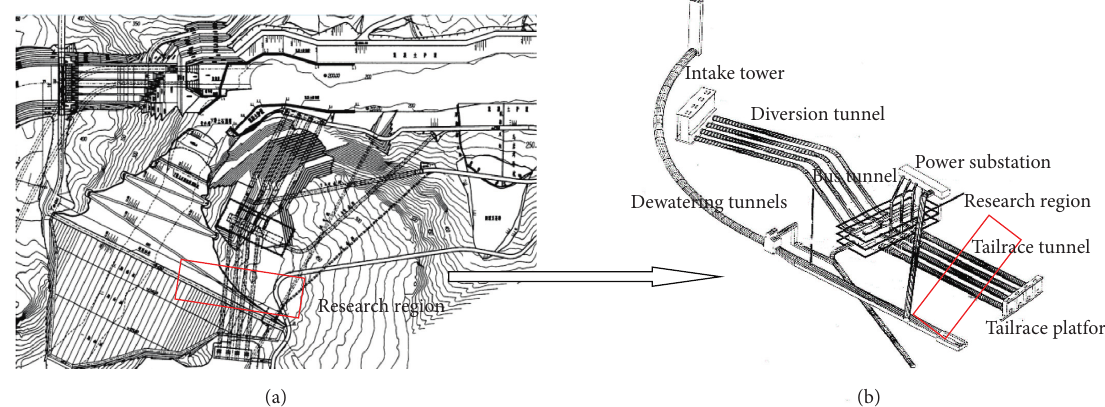
Figure 5: Underground cavern tunnel structure diagram. (a) Shuibuya hydropower station. (b) Underground